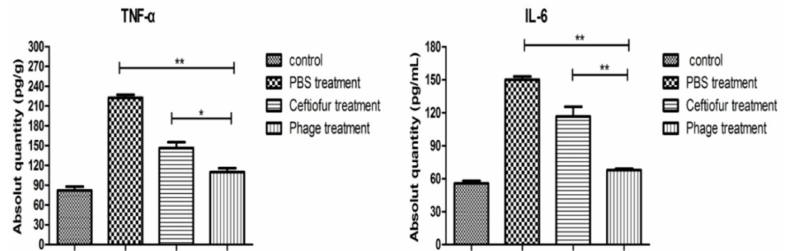
Figure 9. Concentration of TNF- α and IL-6 after phage treatment using an induced mastitis model in mice. The concentrations of IL-6 and TNF- α in mice mammary tissues decreased significantly. The results are reported as the mean titer ± SD for four mice per group. *, p < 0.05; **, p < 0.01.